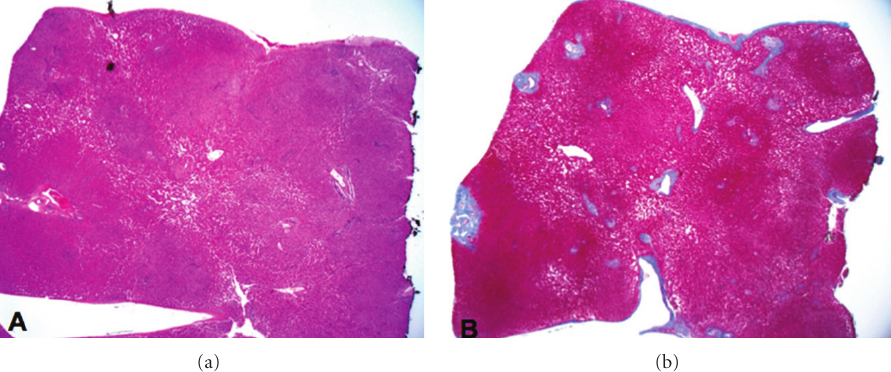
Figure 5: Liver wedge resection. (a) This is a wedge resection specimen demonstrating multiple vaguely defined nodules which are hypercellular. These nodules are di ff usely presented and are centered around portal triads. There is no steatosis, cholestasis, or lobular inflammation. (b) The trichrome stain accentuates the nodular pattern and reveals no significant fibrosis. These morphologic features are diagnostic of nodular regenerative